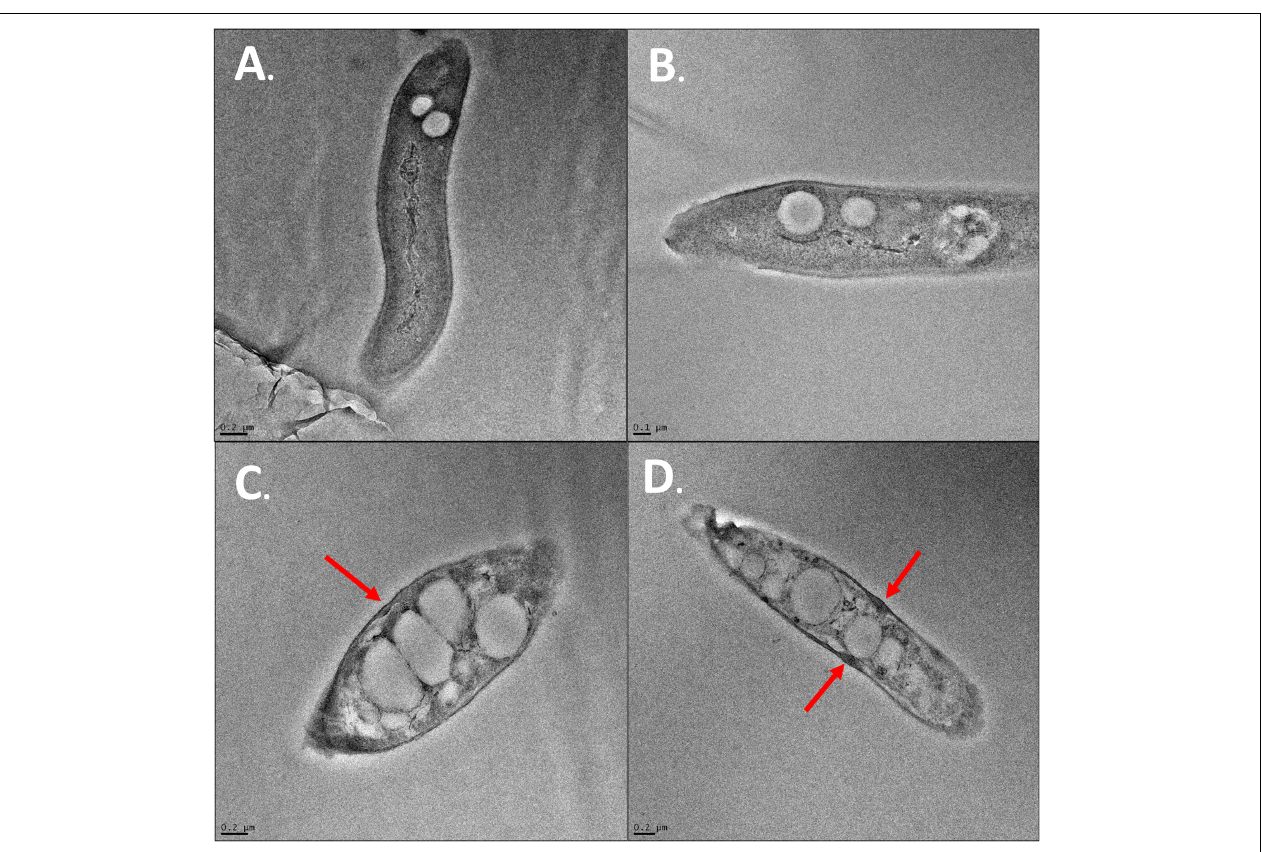
FIGURE 10 | TEM images of S. scabies. (A) S. scabies positive control grown overnight in nutrient broth. (B) S. scabies grown overnight in the presence of 4% DMSO (C,D) S. scabies grown overnight in the presence of 4% DMSO and SG at MIC. Red arrows indicate bulges in the cell membrane of SG treated cells. Images were taken using an FEI Tecnai G2 F20 TEM (FEI company, OR, United